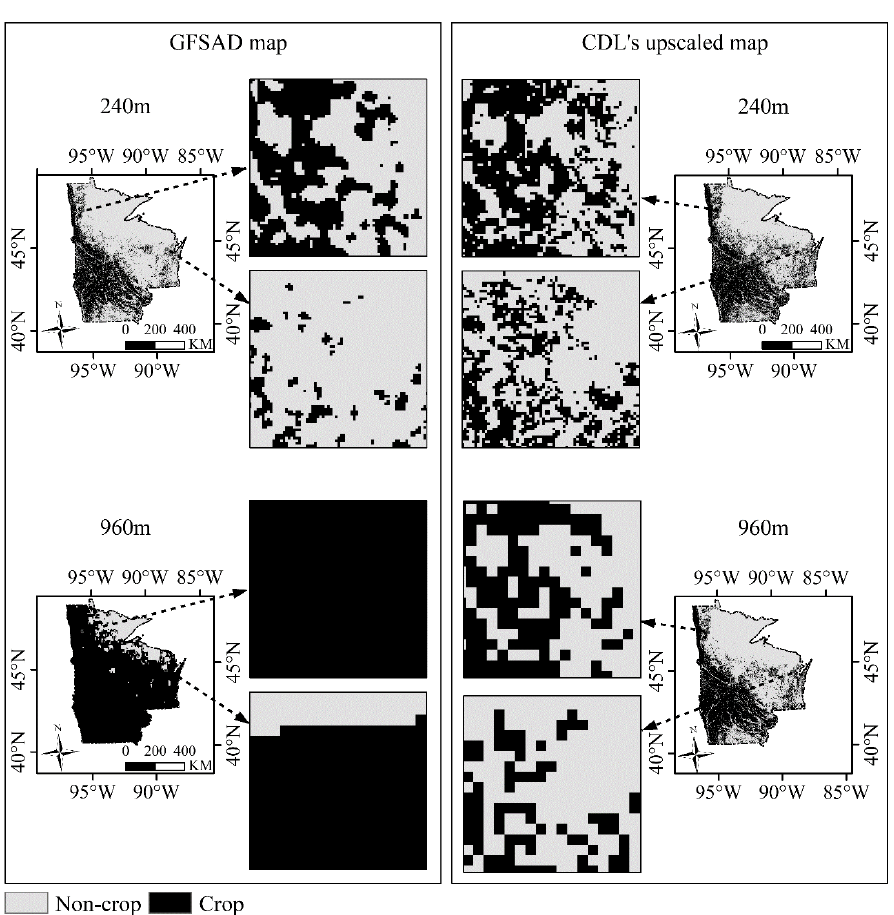
Figure 8. An example of difference between upscaled maps and the Global Food Security-Support Analysis Data (GFSAD) maps for 240 m and 960 m, respectively, for the region of Upper Midwest. The left panel presents the GFSAD maps at 240 m and 960 m, respectively. The right panel presents the upscaled maps at 240 m and 960 m, respectively.